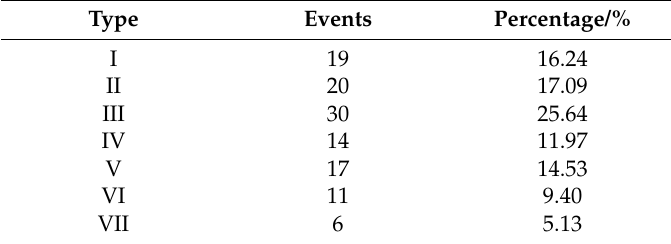
Table 2. Summary of mode hyetograph types in Yangpu District.